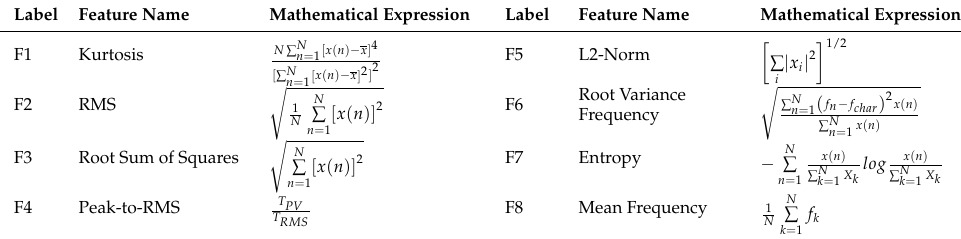
Table 4. Mathematical representation of selected